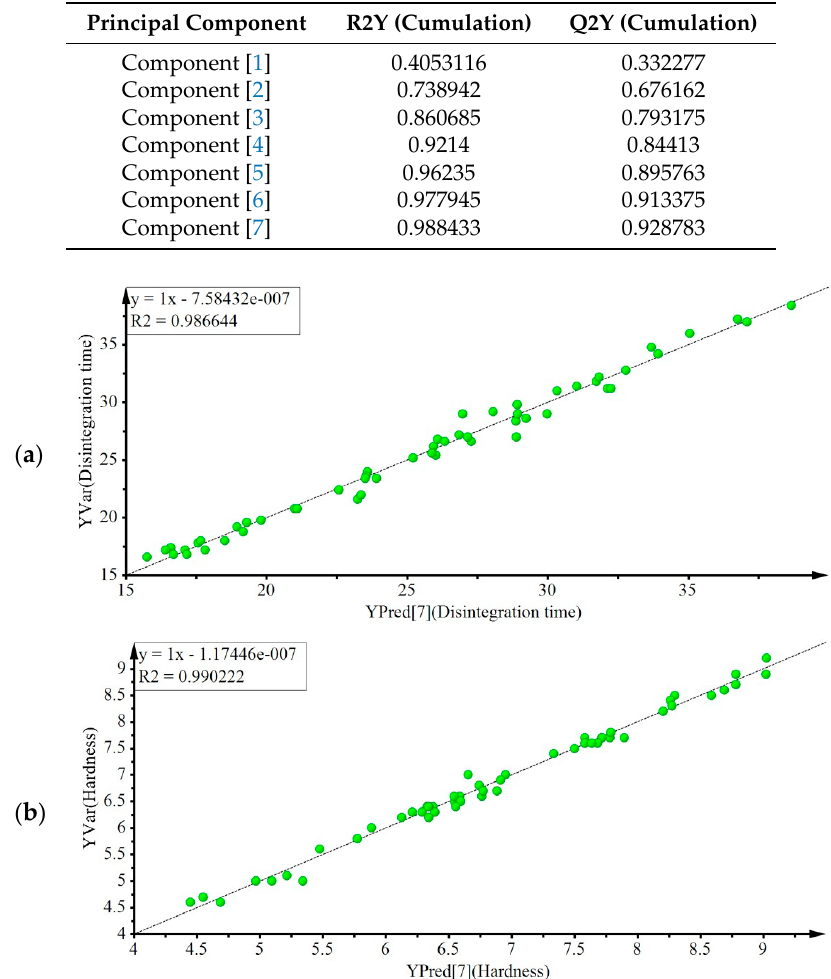
Figure 3. Predicted vs. measured plots in partial least squares model for ( a ) disintegration time; ( b ) hardness